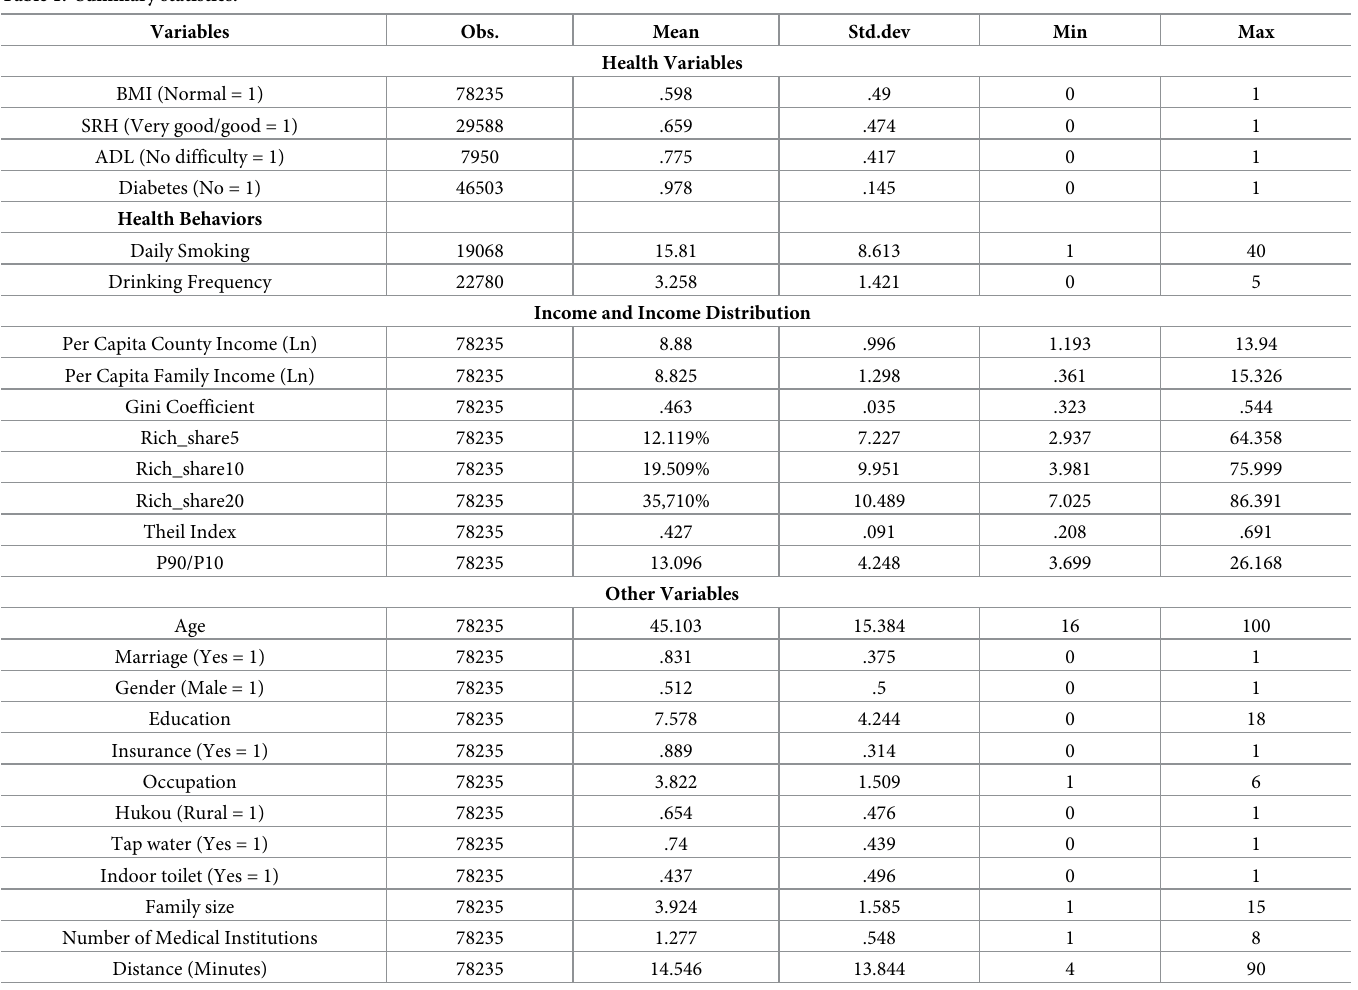
Table 1. Summary